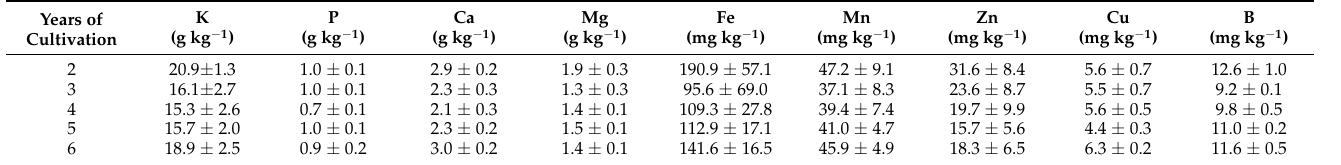
Figure 3. Changes over cultivation years in fresh weights of ginseng roots. Mean values ± standard errors ( n = 3). Table 1. Changes over cultivation years in mineral concentrations (dry-weight basis) in the ginseng roots.